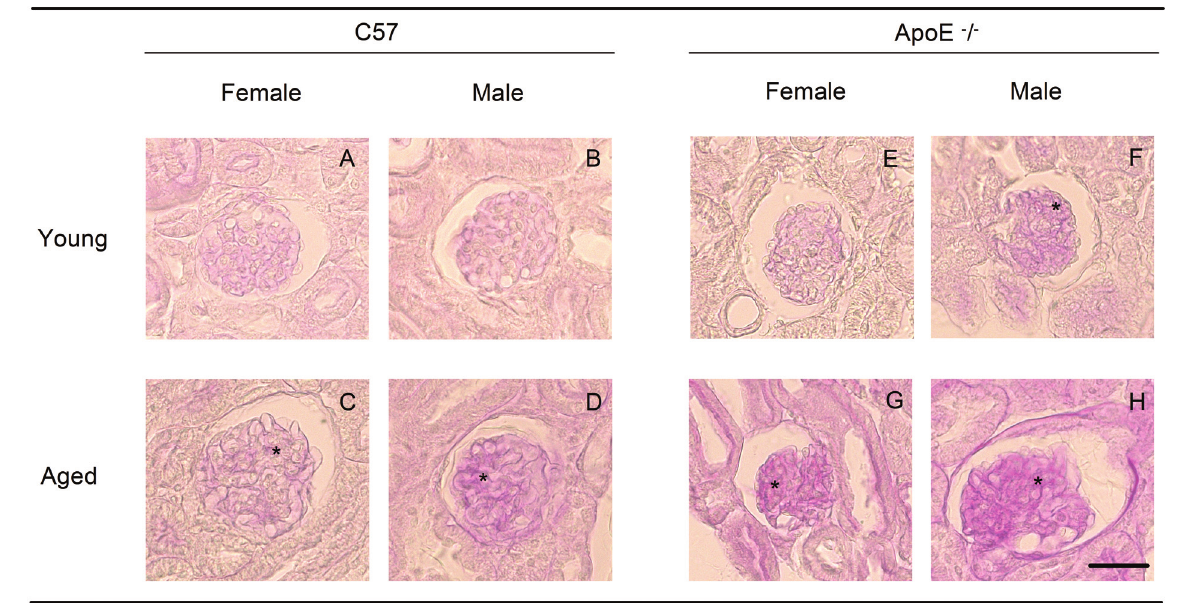
Figure 1. Renal cortex from young and aged male and female C57 and ApoE -/- mice. The sections were stained with periodic acid Schiff for the assessment of mesangial expansion, as indicated by asterisks. In C57 mice, young females ( A ) and males ( B ) presented similar histological features. The aging process led to mesangial expansion in both female ( C ) and male ( D) animals; however, these alterations were more prominent in males. Young ApoE -/- male mice ( F ) already present expansion of the mesangial matrix compared to female ApoE -/- animals ( E ). Aging also exacerbates this disturbance similarly in both female ( G ) and male ( H ) ApoE -/- animals. Scale bar: 25